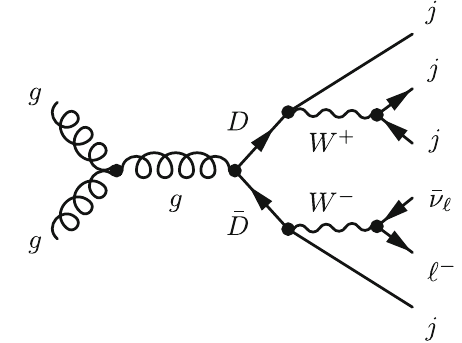
Fig. 1 One of the LO Feynman diagrams for the pair-production of a D -type VLQ. Here, g corresponds to gluons from initial colliding protons. The D -quark decays into a light jet j = u , c , ¯ u , ¯ c and a W boson, with one of the W ’s further decaying via a leptonic channel, with one charged lepton ( (cid:7) − = e − ,μ − ) and the corresponding neutrino ( ¯ ν e , ¯ ν μ ), and the other decaying via a hadronic channel into light jets. In the hadronic W decay, both the up- and down-type SM quarks are